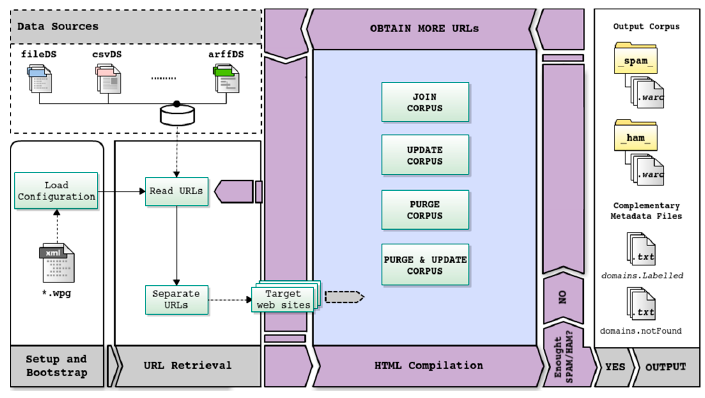
Figure 1. Main WARCProcessor workflow showing the supported use cases.